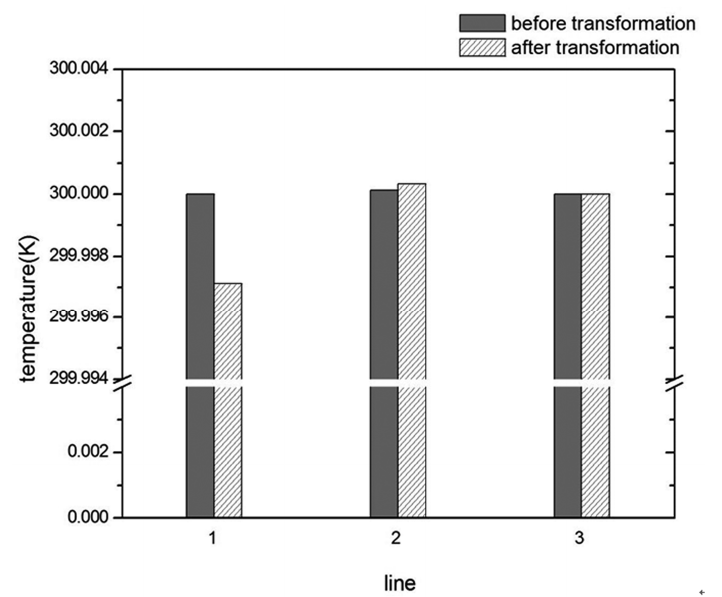
Figure 11. The average temperature changes on the three observation lines before and after the planned transformation.